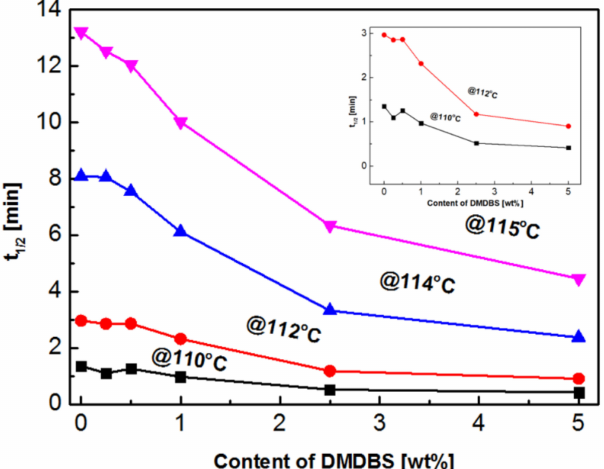
Figure 5. Changes of the crystallization half-time, t 1/2 , as a function of the DMDBS content for OBC/DMDBS composites at different isothermal crystallization temperatures. Note: Inset is a separate image of t 1/2 as a function of DMDBS